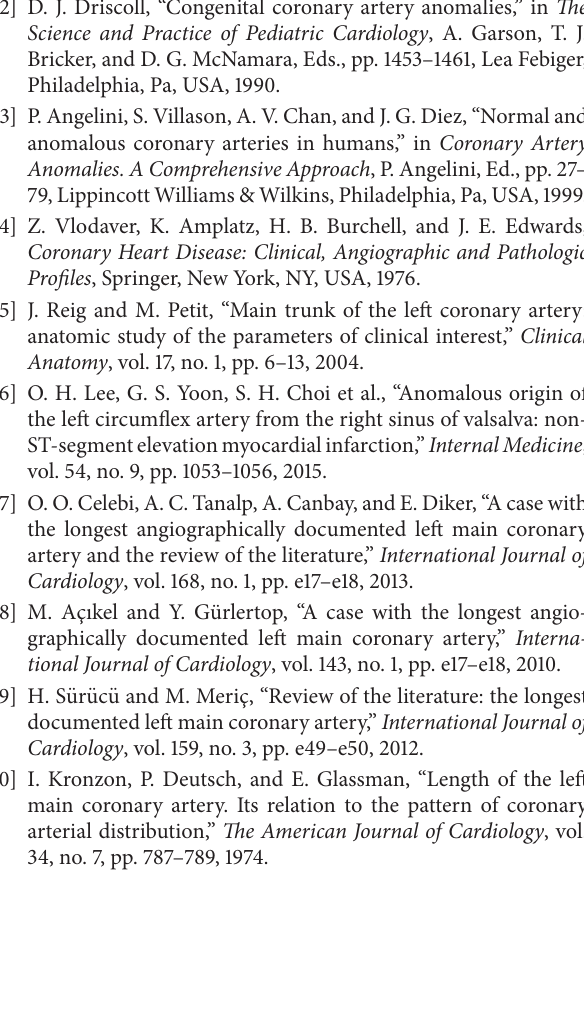
Figure 6: Superdominant RCA arising from right sinus in left anterior oblique view on